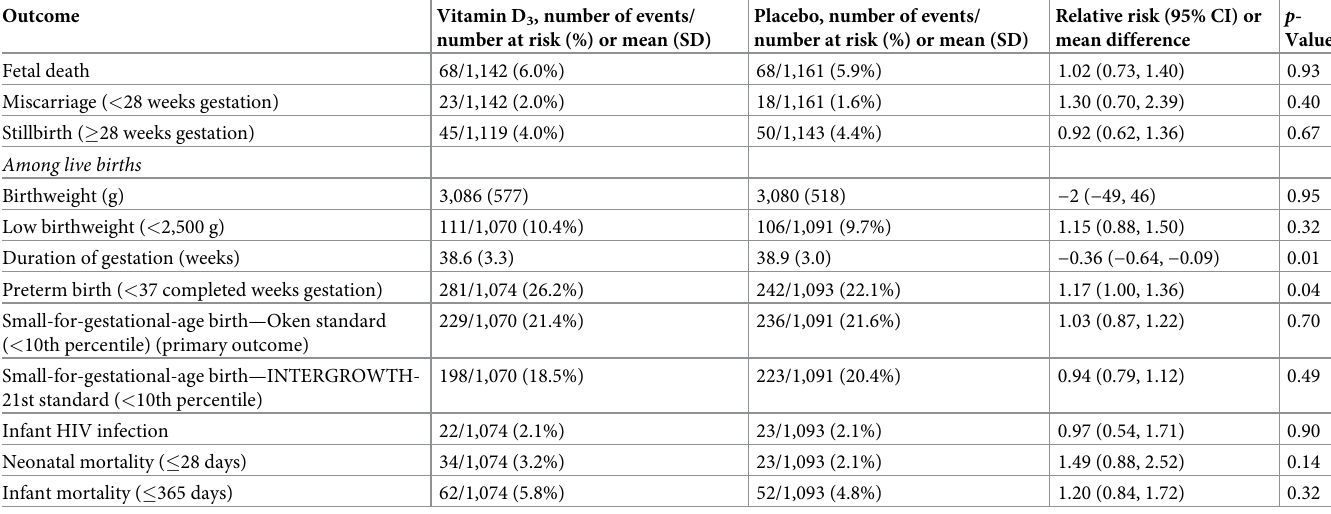
Table 3. Effect of maternal vitamin D 3 supplementation on small-for-gestational-age live births and secondary birth and infant outcomes. Outcome Vitamin D 3 , number of events/ number at risk (%) or mean